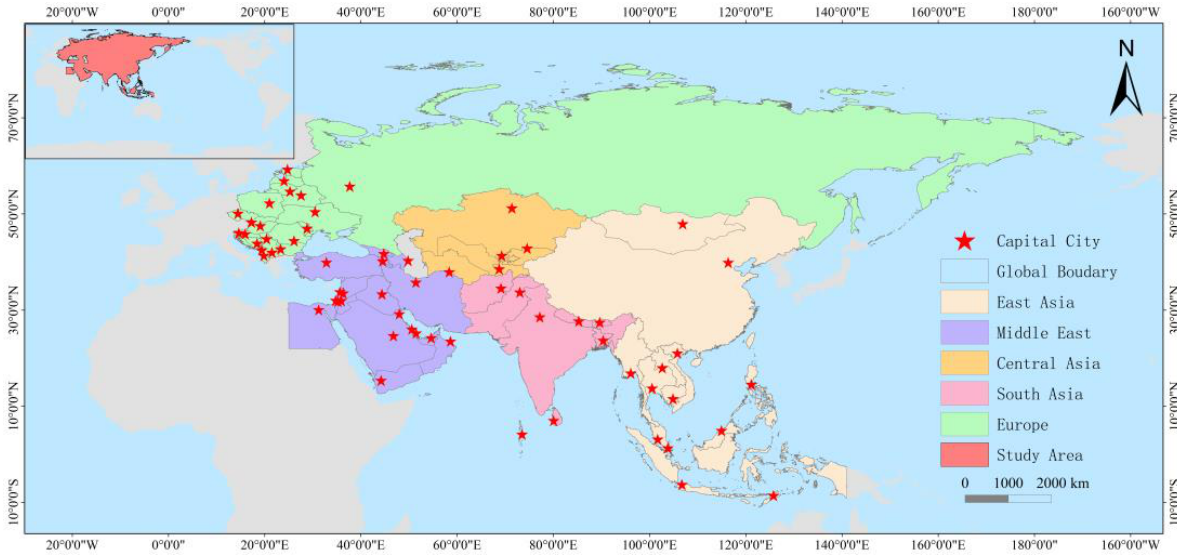
Figure 1. Location of the Pan-Third Pole region. Table 1. The countries in different geographical zones throughout the Pan-Third Pole region. Geographical Zone